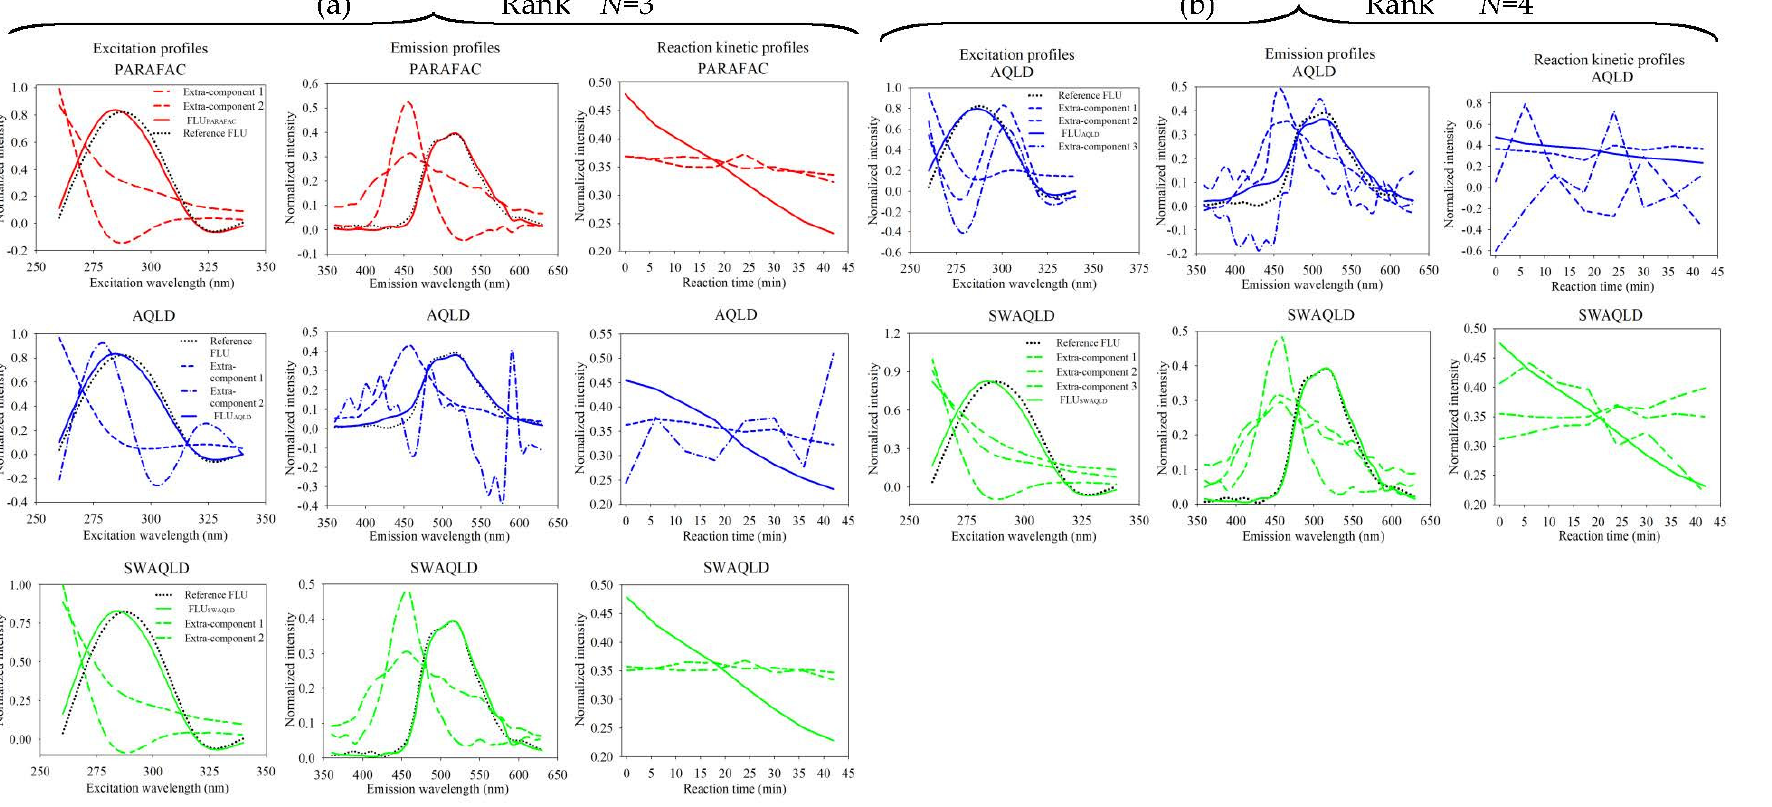
Figure 4. Resolved excitation, emission, and kinetic profiles, normalized to unit length obtained from PARAFAC, AQLD, and SWAQLD for the analysis of four-way phosphorescence data of free-interference water samples with a rank N = 3 ( a ) or 4 ( b ). The black dotted lines denote the FLU reference profiles. The red, blue, and green solid lines represent the FLU-resolved profiles obtained from PARAFAC, AQLD, and SWAQLD, respectively. Other extracted profiles represent additional extracted components.